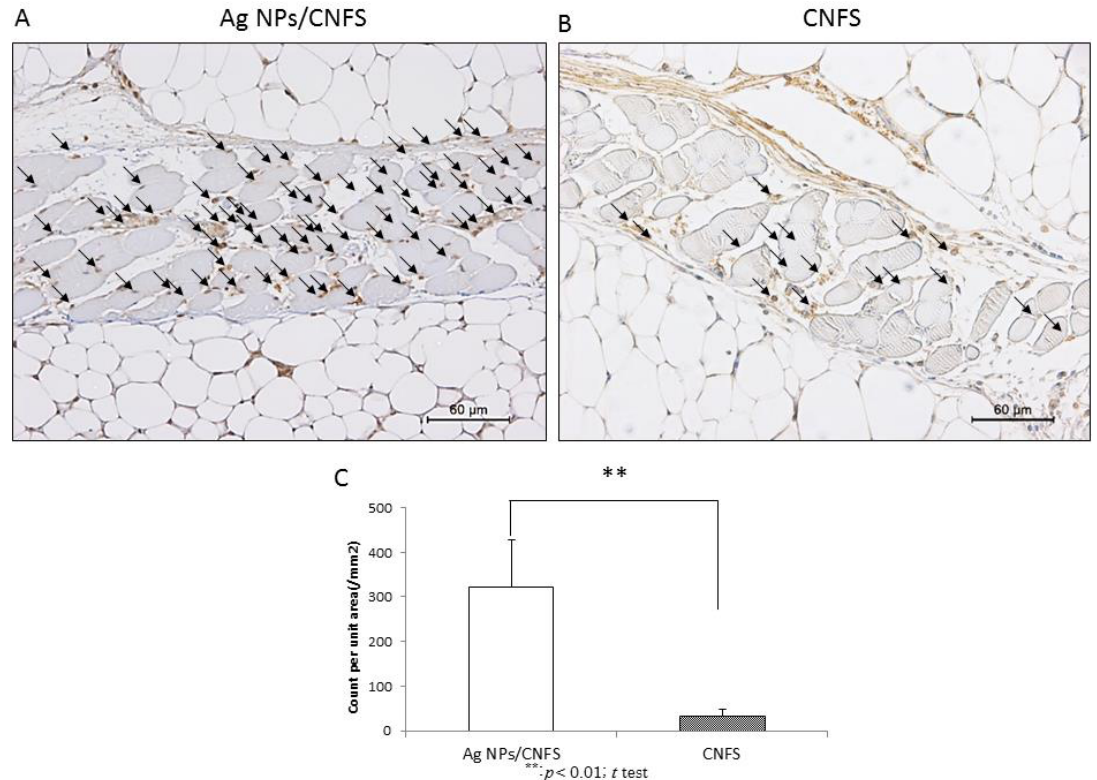
Figure 5. Effect of Ag NPs/CNFS or CNFS treatment on oxidative stress in skin. Immunohistochemical (8-hydroxy-2′-deoxyguanosine, 8-OHdG) staining of skin sections was performed to measure the proportion of 8-OHdG-positive sites 1 day after treatment with either Ag NPs/CNFS ( A ) or CNFS ( B ). A significant increase in the number of 8-OHdG-positive sites was observed in the Ag NPs/CNFS group compared with the CNFS group. The arrows show the 8-OHdG-positive sites. Each microphotograph is representative of six samples ( A , B ). The number of 8-OHdG-positive sites in microphotograph of each sample ( n = 6) were statistically analyzed ( C ). Data represent the mean ± SD of 6 determinations, ** Student’s t test, p < 0.01 ( C ).